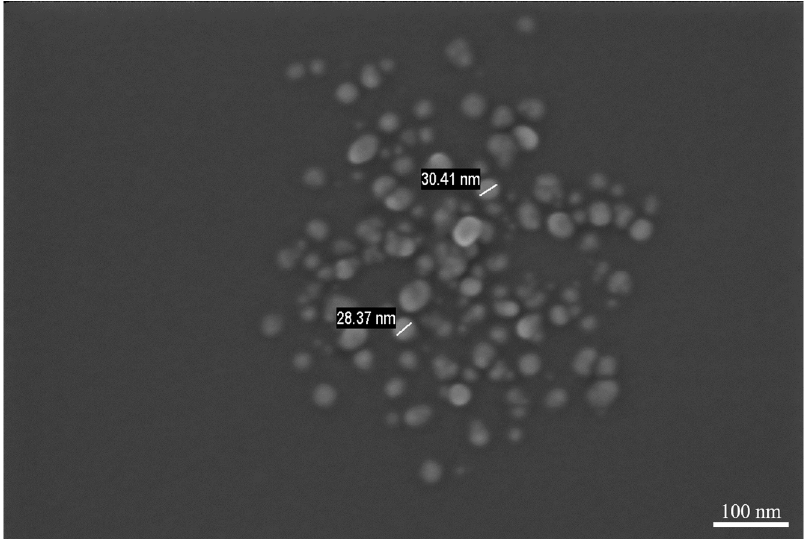
Figure 11. Image of nanoparticles obtained after the condensation process, on a clean silicon substrate, without CNW template, at 550 °C.